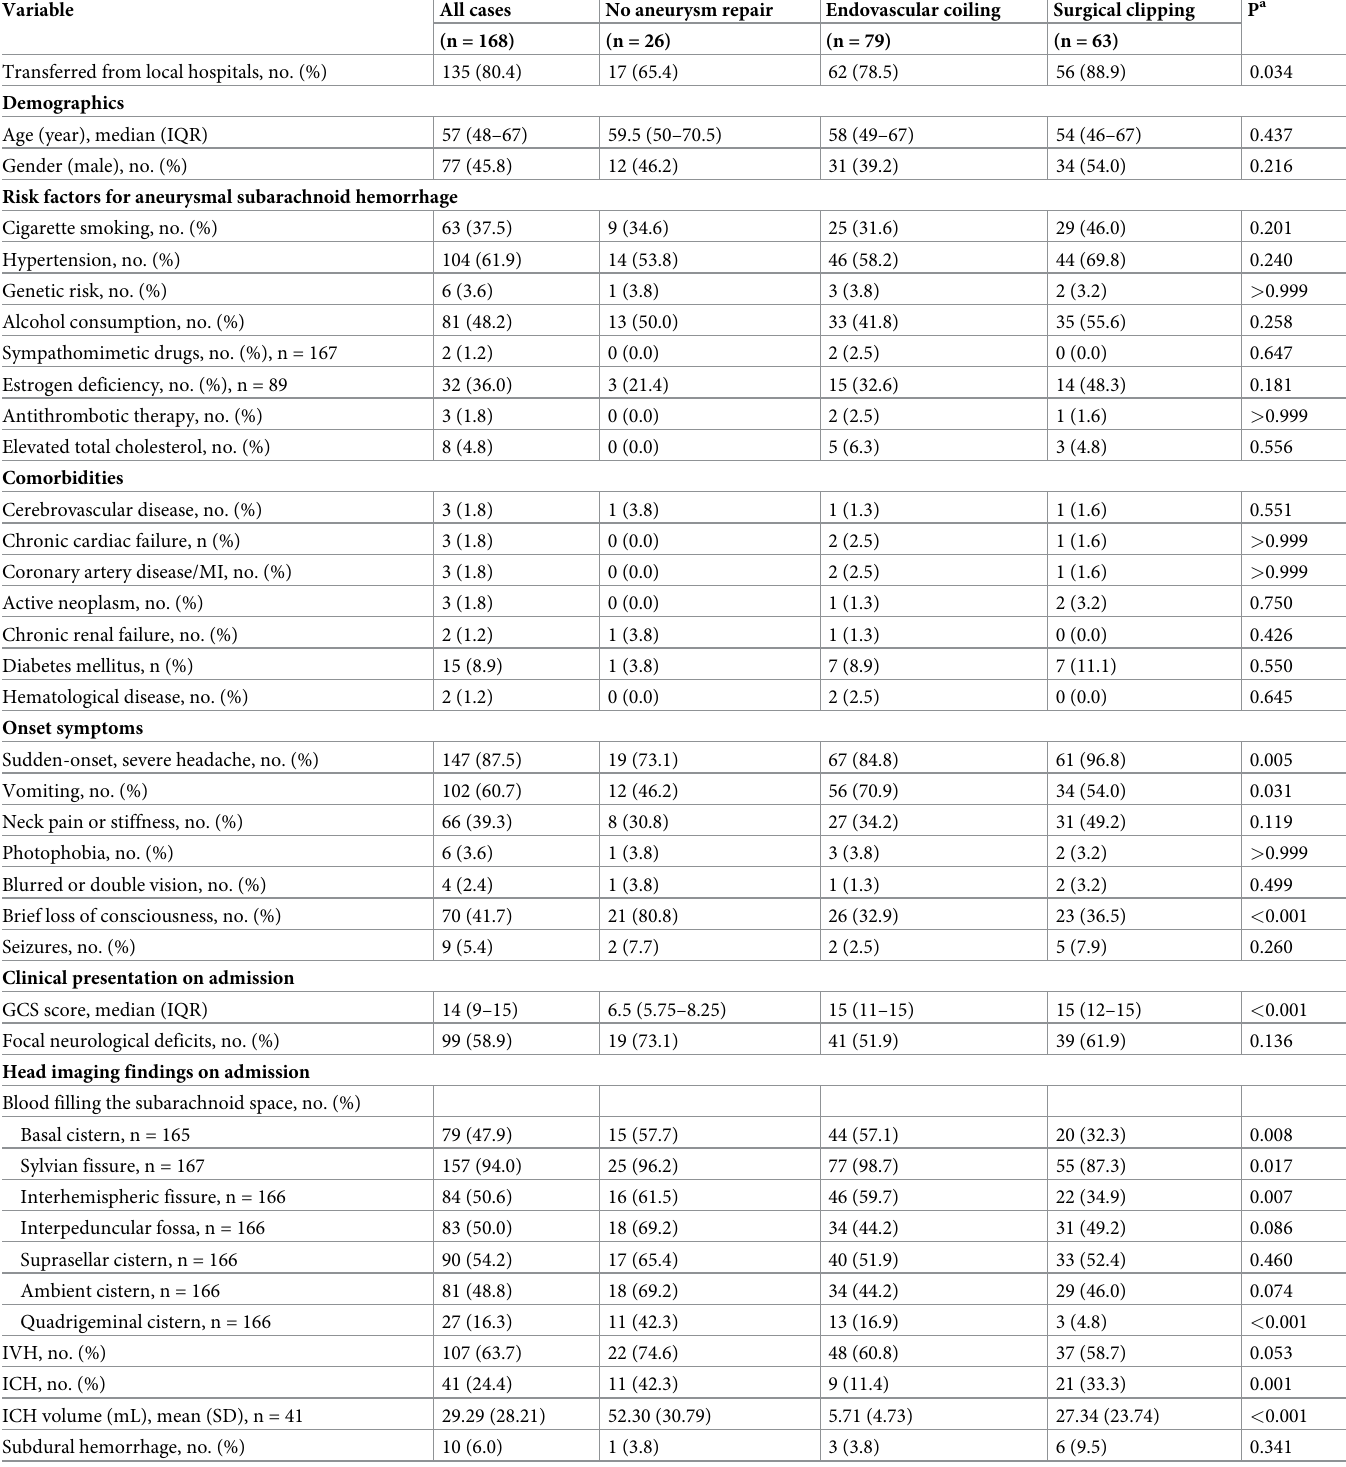
Table 1. Demographic and baseline characteristics, management and outcomes of patients with aneurysmal subarachnoid hemorrhage according to methods of aneurysm